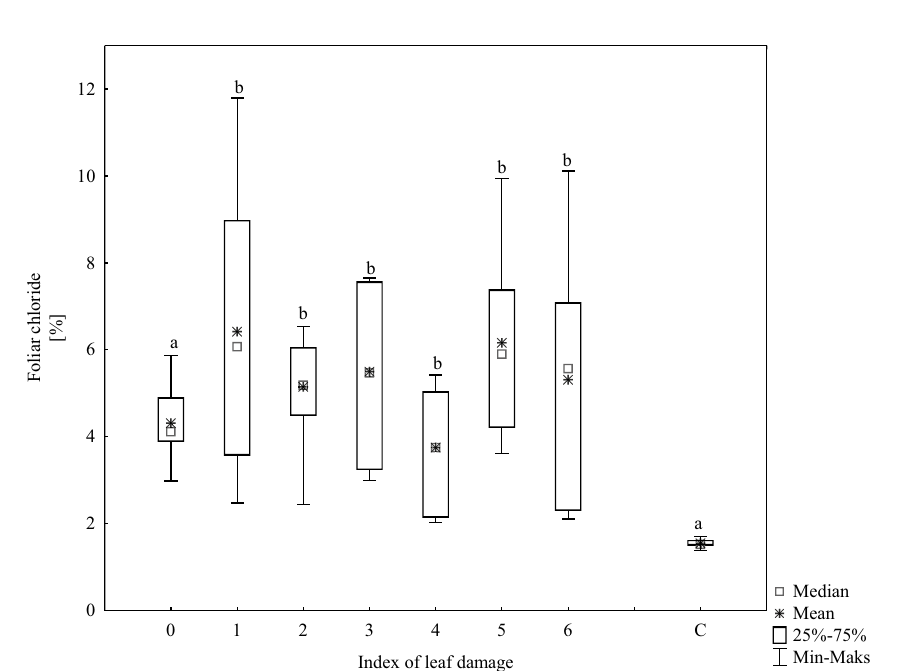
Figure 2. Chloride concentrations in foliage samples. C = park trees (control, n = 5), 0–6 = roadside trees (n = 10 per leaf damage severity). Results with the same letter are not statistically different (Kruskal–Wallis test, p <